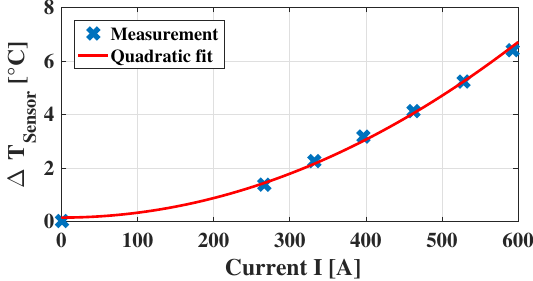
Figure 7. Rise of the heat-sink temperature (cid:49)T sensor due to the power dissipated in the shunt resistor and fit to the quadratic